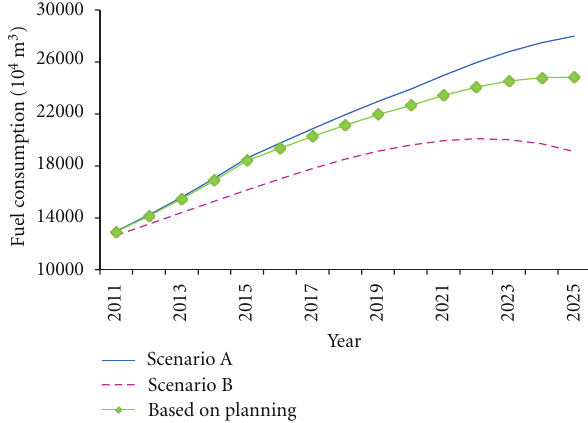
Figure 5: Forecast curve of China’s vehicle fuel consumption under the implementation of Planning